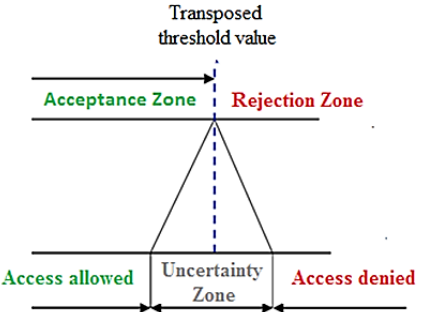
Figure 11. Acceptance, rejection and uncertainty zones . Table 3. Example of the proposed temperature screening protocol in indoor conditions.